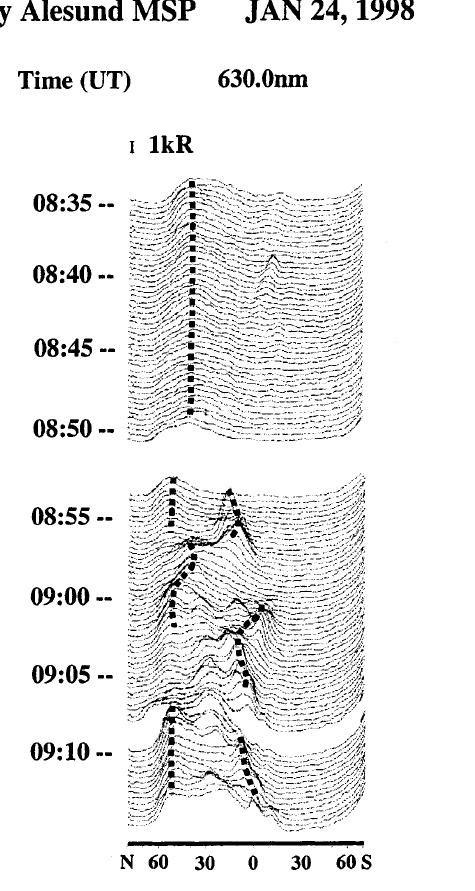
Fig. 2. Intensity of the 630.0 nm emission measured by the meridian scanning photometer at Ny-A˚ lesund on the morning of 24 January, 1998, as a function of